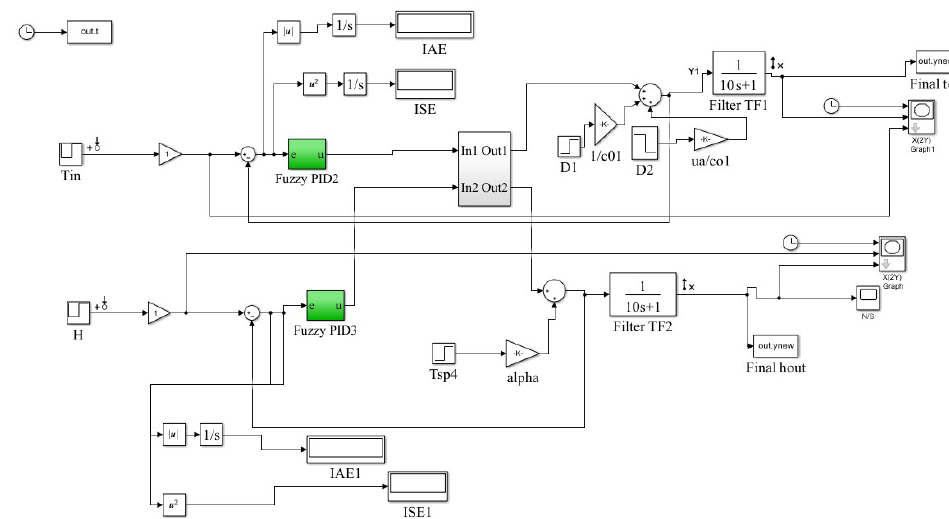
Figure 13. MATLAB/SIMULINK Diagram of Closed-Loop Greenhouse Model with Fuzzy PID Controller. Table 5. Tuning parameters of conventional controllers for